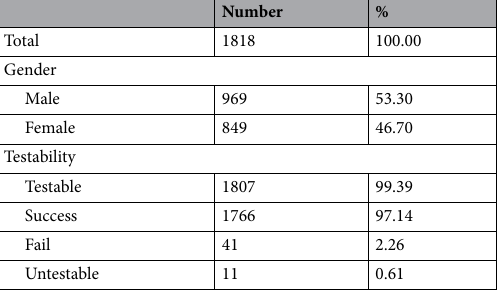
Table 1. Characteristics of Study